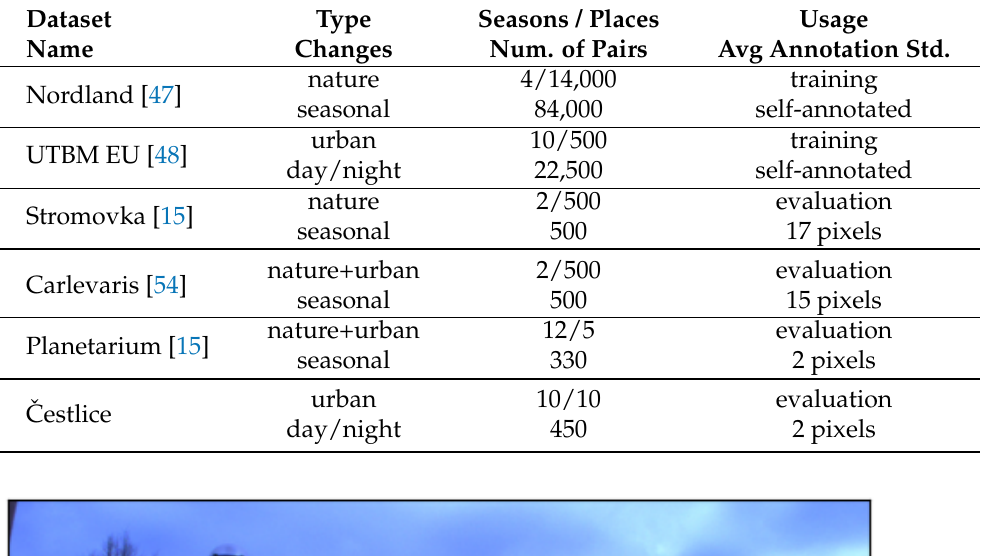
Table 2. This table summarizes all the information about datasets used. Each dataset contains images taken from the same place across multiple seasons. All the possible unique combinations of seasons are used.